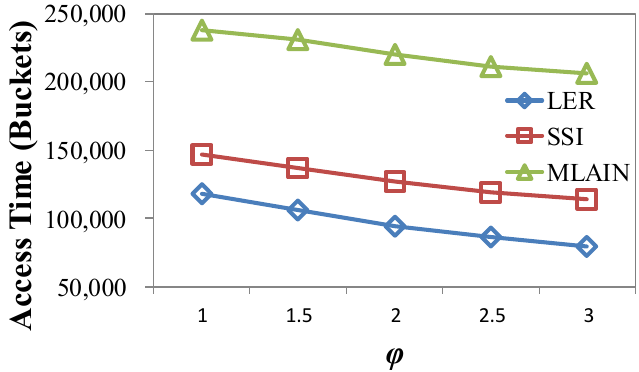
Figure 13. Average access time for changing φ values . Table 5. Average tuning time for changing φ values .